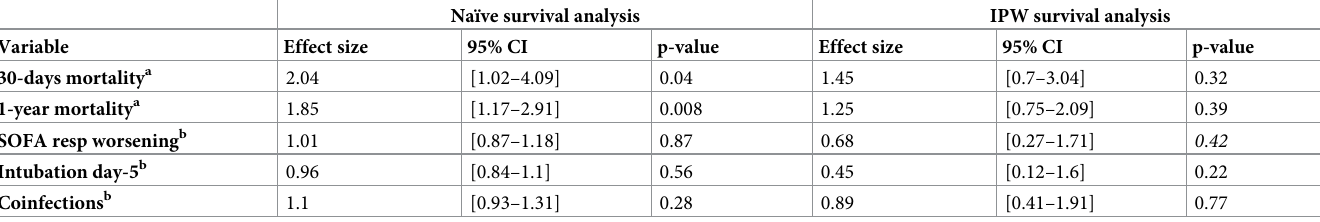
Hazard Ratio b Odd ratio. SOFA = Sequential Organ Failure Assessment Score, SOFA resp = respiratory